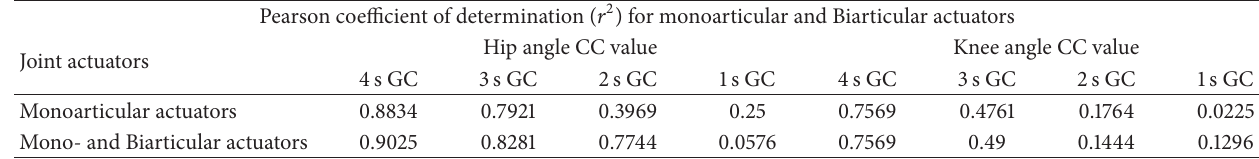
Table 3: Pearson coefficient of determination ( 𝑟 2 ) for mono-articular (alone) and with addition of bi-articular actuators. Pearson coefficient of determination ( 𝑟 2 ) for monoarticular and Biarticular actuators